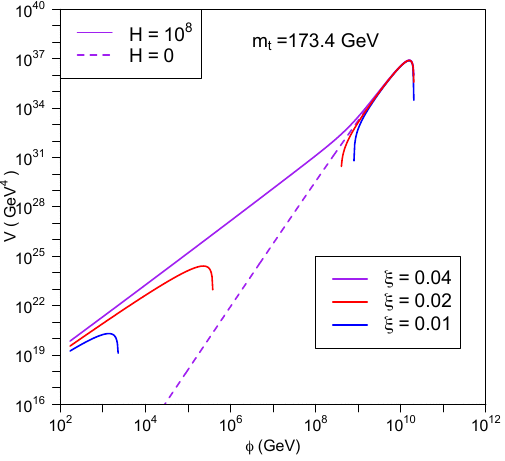
Figure 2 . The e(cid:11)ective Higgs potential plotted as a function of the Higgs (cid:12)eld for (cid:22) 2 = 0 and a range of curvature couplings (cid:24) at 170 GeV. There is a single maximum for large expansion rate H or (cid:24) , but new maxima and minima appear for small H and (cid:24) .